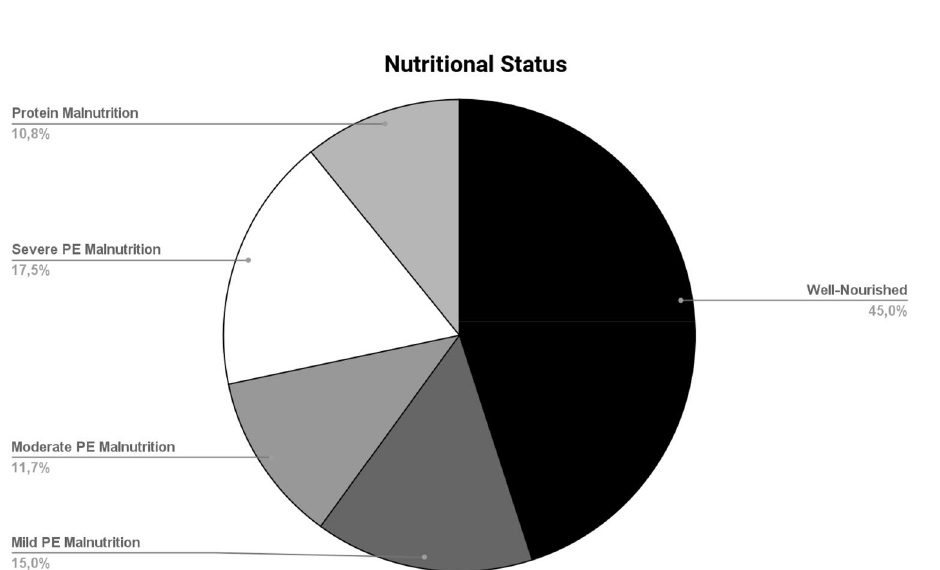
Figure 2. Nutritional status. Data are expressed as percentages. PE